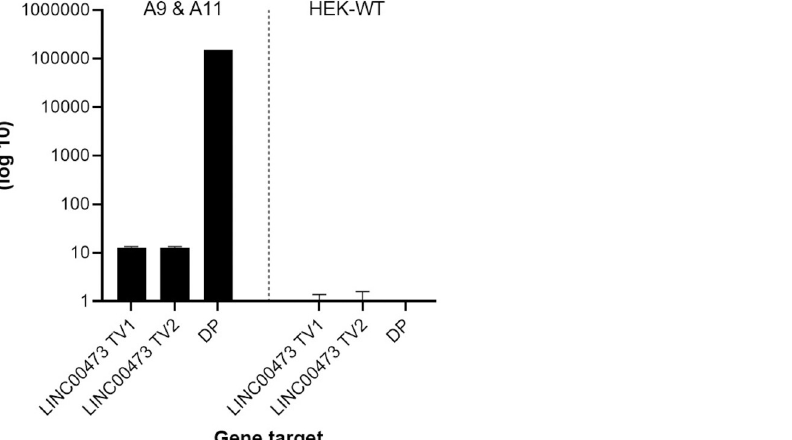
Fig 3. Expression of LINC00473 is upregulated in HEK-DP clones. (a) The two known transcript variants ( TV1 and TV2 ) of LINC00473 are significantly upregulated in A9 and A11 clones. The expression of the DNAJB1-PRKACA fusion transcript (DP) is demonstrated in A9 and